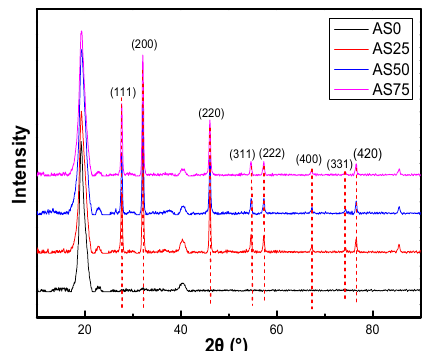
Figure 8. XRD (X-ray diffraction ) pattern of Hydrogels.